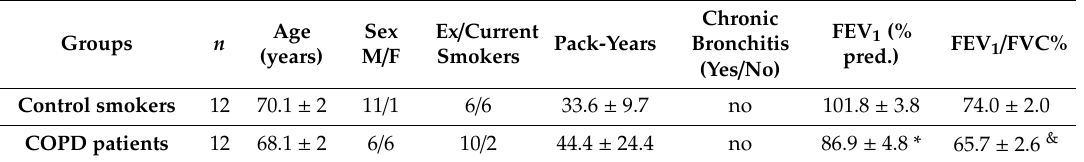
Table 2. Characteristics of COPD and control subjects who provided peripheral lung tissue for immune-histochemical